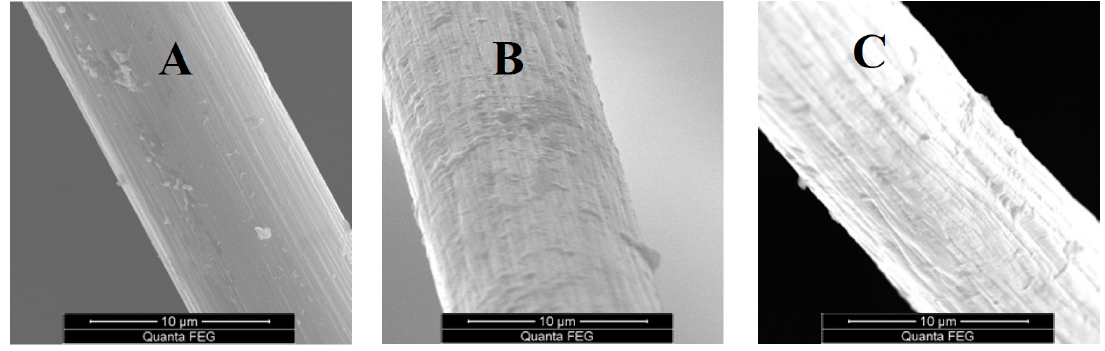
Figure 7. SEM pictures of carbon fibers: ( A ) original; ( B ) 500 °C for 30 min; ( C ) 500 °C for 10 h.